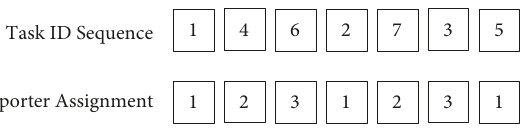
Figure 3: Chromosome representation in block transportation